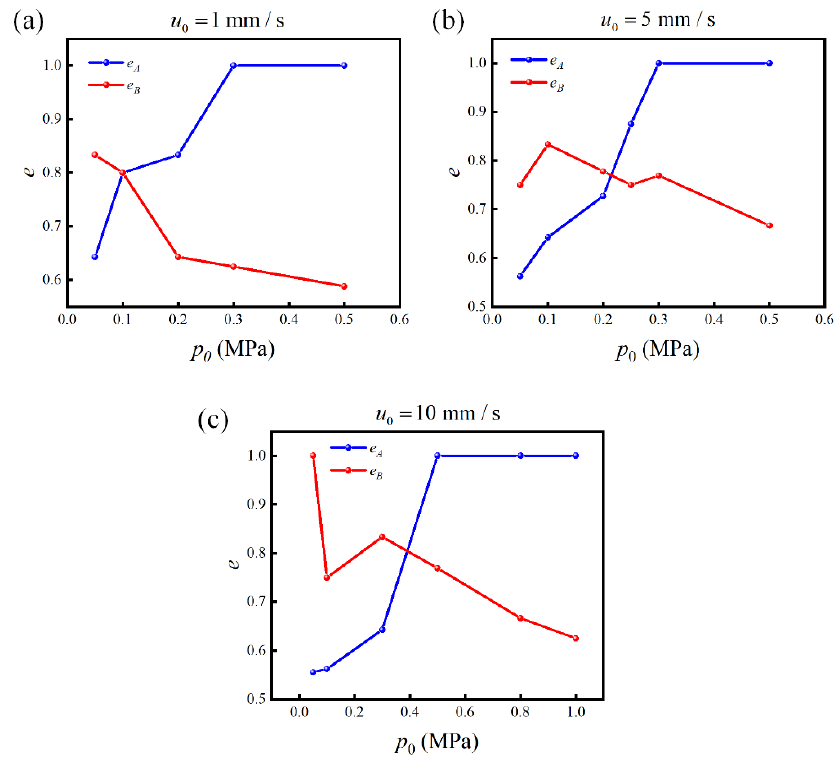
Figure 6. Relationship between the separation efficiencies 𝑒 𝐴 and 𝑒 𝐵 of particles A and B, respec- tively, with the incident acoustic pressure 𝑝 0 under the flow velocity conditions: ( a ) 𝑢 0 = 1 mm/s . ( b ) 𝑢 0 = 5 mm/s . ( c ) 𝑢 0 = 10 mm/s .